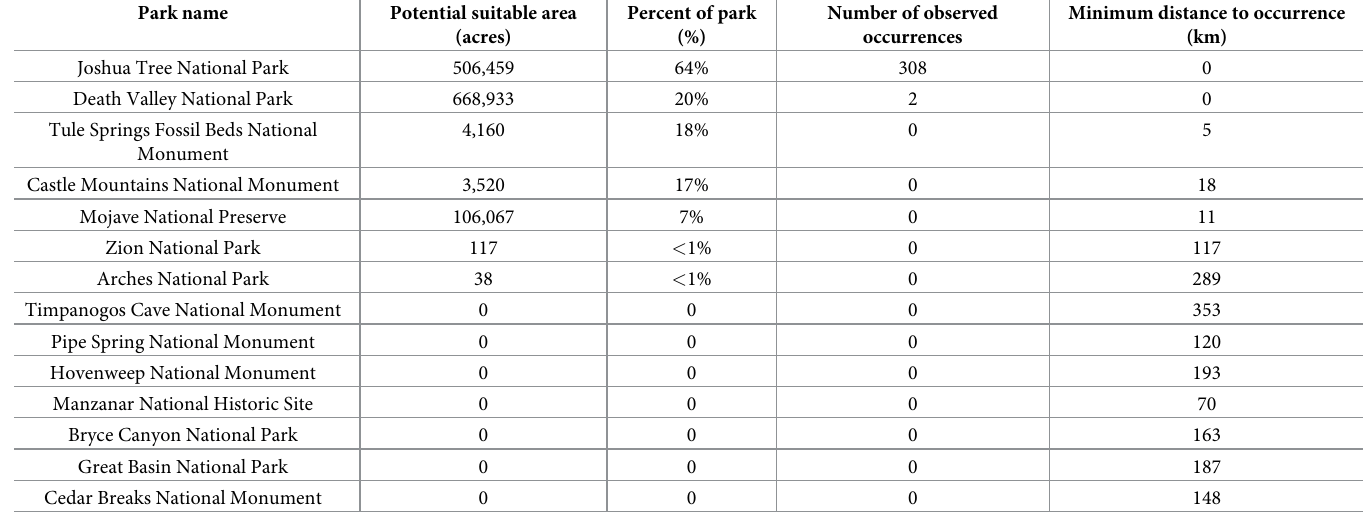
Table 2. Regional analysis table for a) fountain grass ( Pennisetum setaceum ) in Lake Mead EPMT unit including the potential suitable area for the one percentile threshold, percent of park is the percent of the park area that is classified as potentially suitable, number of observed occurrences indicates if presence locations from the park were available for model development, and minimum distance to occurrence is the minimum distance from the park boundary to a known occurrence used in model development.